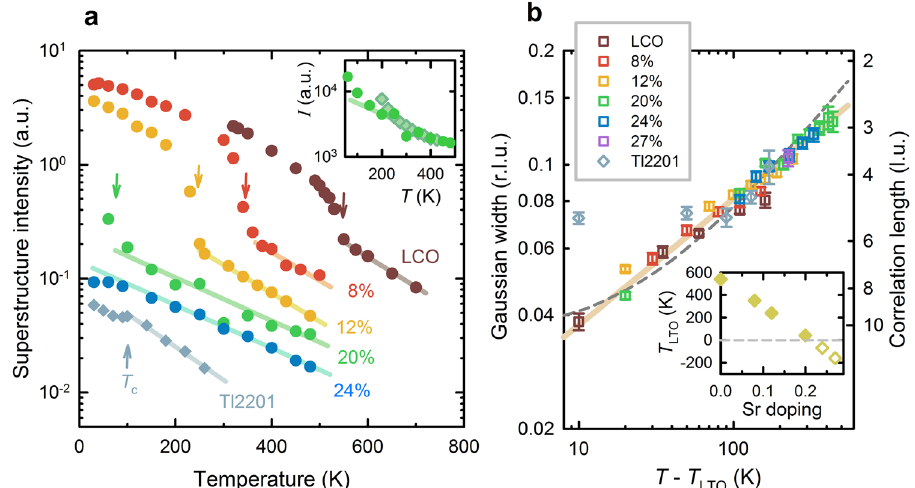
Figure 3. Universal behaviour and scaling of short-range orthorhombic correlations. ( a ) Temperature- and doping dependence of diffuse LTO superstructure intensity in La 2 CuO 4 (LCO, x = 0), La 2-x Sr x CuO 4 (LSCO, values of x indicated in figure) and Tl 2 Ba 2 CuO 6+δ (Tl2201) obtained from X-ray scattering (see Methods for reciprocal space positions). Above the HTT-LTO transition at T LTO (arrows), the intensity decreases exponentially, at a nearly doping- and compound-independent rate of ~ 1/200 K -1 . The x = 0.24 LSCO sample does not show long-range LTO order, yet short-range correlations are still observable at 480 K. The Tl2201 sample is slightly overdoped, also shows no long-range orthorhombicity, and exhibits a clear change of the diffuse intensity below T c = 89 K. Intensities for LSCO are normalized to the nearest Bragg peaks at 30 K, and therefore directly comparable; the intensity for LCO is normalized to the LTO superstructure peak at 300 K. The Tl2201 data are shifted vertically by an arbitray constant for clarity. Inset: comparison between X-ray (circles, x = 0.2) and quasielastic neutron (diamonds, x = 0.155) diffuse intensity above T LTO reveals similar exponential behaviour. The neutron data are for the (1.5 1.5 2) LTO peak, normalized to coincide with X-ray data at high temperatures. ( b ) Gaussian width σ of the diffuse LTO superstructure peaks vs. T – T LTO . Master curve (solid line): ( T – T LTO ) 1/3 ; dashed line: shifted square-root dependence, ( T – T LTO ’) 1/2 , as expected from rare-region theory, with T LTO ’ = T LTO –25 K. The right axis shows the corresponding correlation length L = 0.41/σ (see Methods), in units of the in-plane tetragonal lattice constant. Inset: T LTO values used in the scaling, including the extrapolated effective negative values for the x = 0.24 and 0.27 samples (empty diamonds). Interestingly, the Tl2201 data above T c approximately follow the universal curve if the effective T LTO is taken to be ~ T c ; the width remains roughly temperature-independent near and below T c